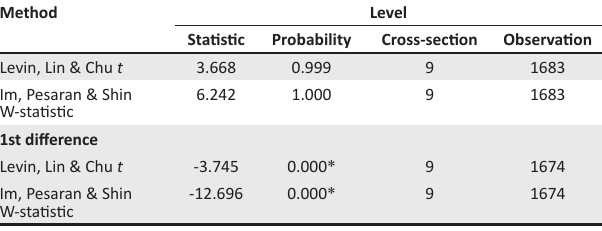
TABLE 7a: Pedroni residual cointegration test. Panels Series with GARCH Common autoregressive coefficients (within-dimension)